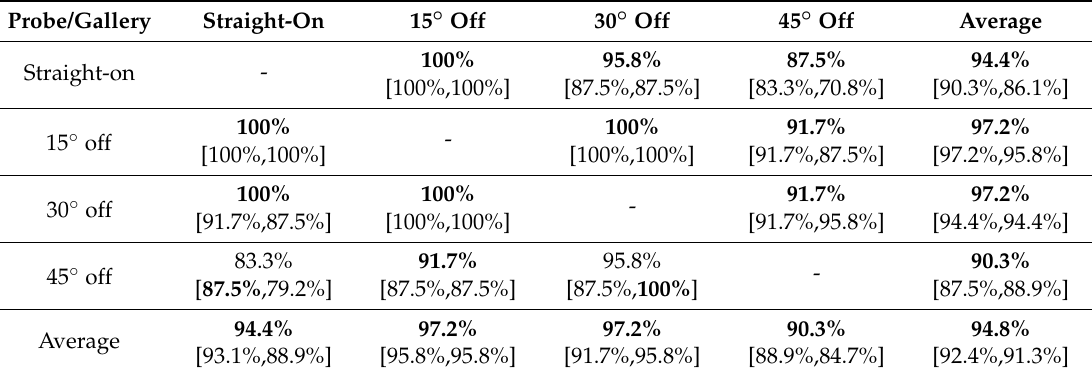
Table 2. The comparison of the proposed approach with similar approaches on pose variation dataset. The best results have been bolded.